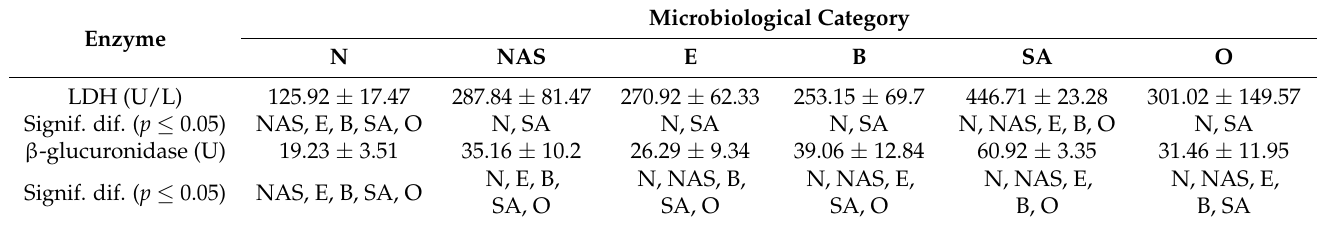
Table 3. Milk LDH and β -glucuronidase activity results (mean ± SD) by microbiological category based on BLAST analysis of 16S rRNA gene sequence in 76 composite mid-lactation milk samples from Carpathian goats without signs of clinical mastitis in